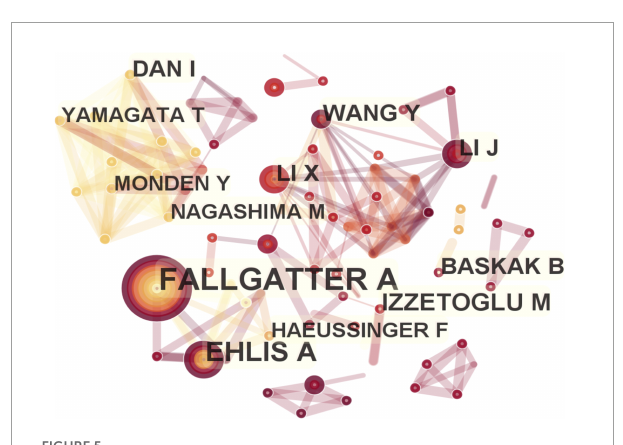
FIGURE5 Map of active authors in functional near-infrared spectroscopy (fNIRS) research on